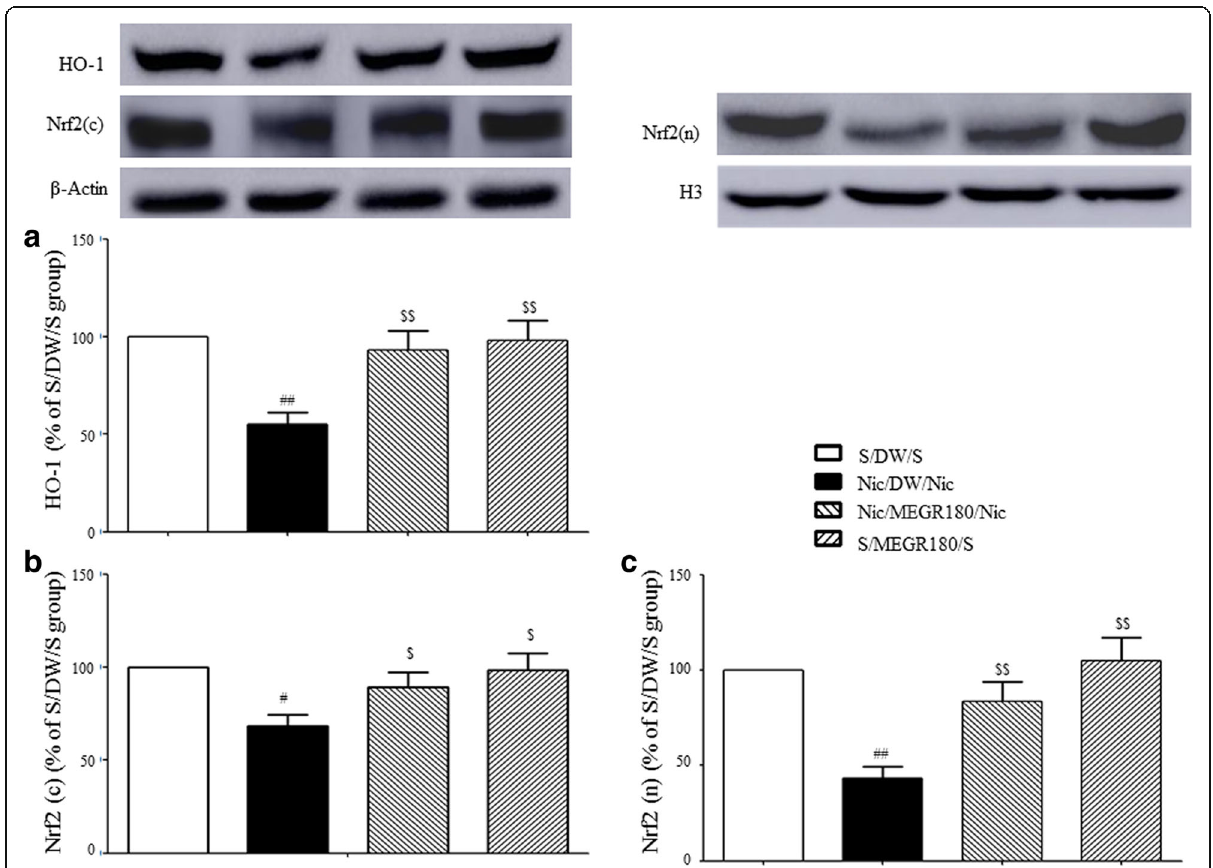
Fig. 4 Effect of MEGR on the Nrf2 and HO-1 expressions in the nicotine-sensitized NaccSh. Immediately after the behavioral test, the protein levels of a cytoplasmic HO-1 and b cytoplasmic and c nuclear Nrf2 in the NaccSh were evaluated by Western blot assays. All data are expressed as means ± SEM ( n = 4). Nic: nicotine, S: saline, H3: Histone H3, S: saline, DW: distilled water, MEGR: methanol extract of G. radix , MEGR180: 180